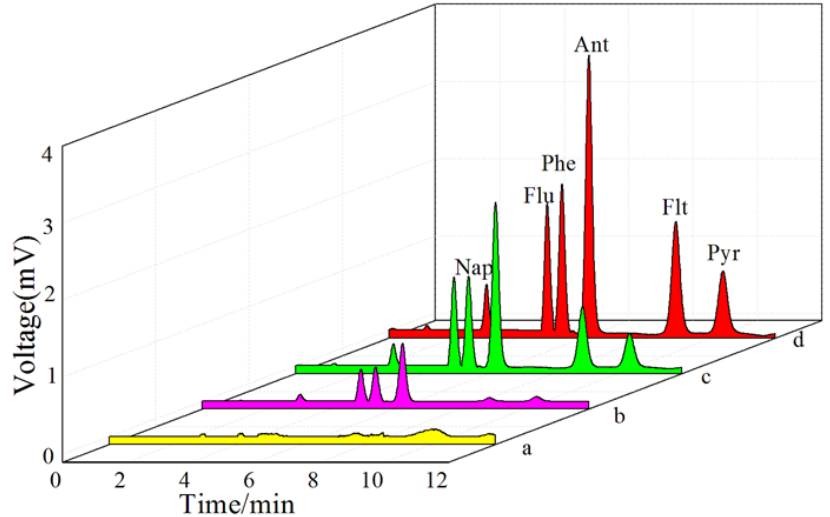
Figure 8. Chromatograms of direct HPLC and SPME-HPLC for PAHs in wastewater. Direct injec- jection ( a ), SPME-HPLC with TiO 2 NTs/Ti fiber ( b ), SPME-HPLC with TiO 2 NTs/Ti fiber spiked tion ( a ), SPME-HPLC with TiO 2 NTs/Ti fiber ( b ), SPME-HPLC with TiO 2 NTs/Ti fiber spiked wastewater at 5 μg·L −1 ( c ) and at 10 μg·L −1 ( d ). wastewater at 5 µ g · L − 1 ( c ) and at 10 µ g · L − 1 ( d